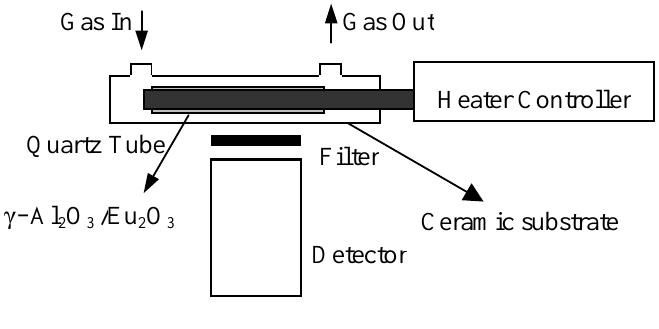
Figure 1. Schematic diagram of the CTL sensing system